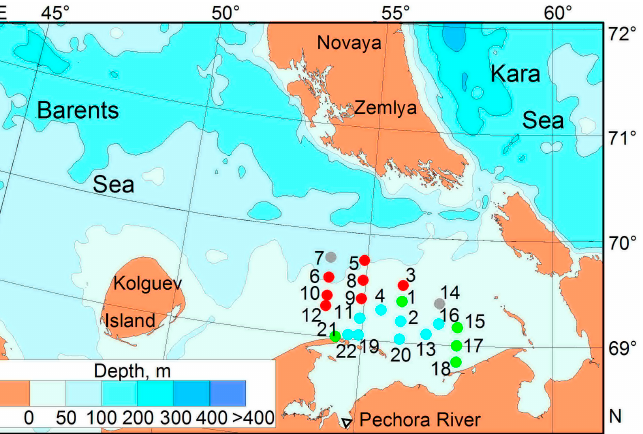
Figure 1 . Location of sampling stations in the south-eastern Barents Sea in summer 2012. Groups of stations based on copepod abundance: red—Cluster 1, cyan—Cluster 2, green—Cluster 3, gray—outliers. Table 1. Summary of sampling stations in the south-eastern Barents Sea in summer 2012. St.